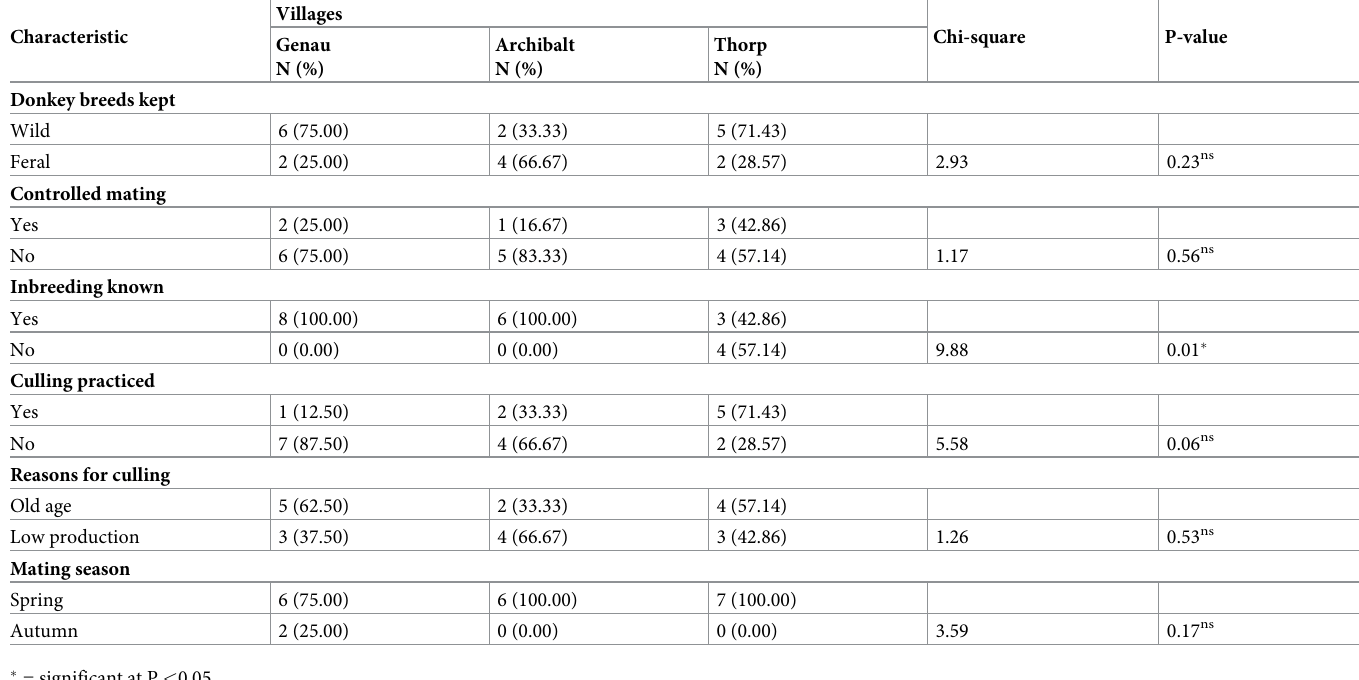
The selection criterions used by the donkey farmers in the three villages are summarized in Fig 2. The results indicated that the donkey farmers used the same selection methods in all three villages (P > 0.05). Growth rate was the most used selection criteria in Genau village while body confirmation was the most used selection criteria in Archibalt and Thorp villages. Table 3. Donkey breeds kept and breeding practices of donkey